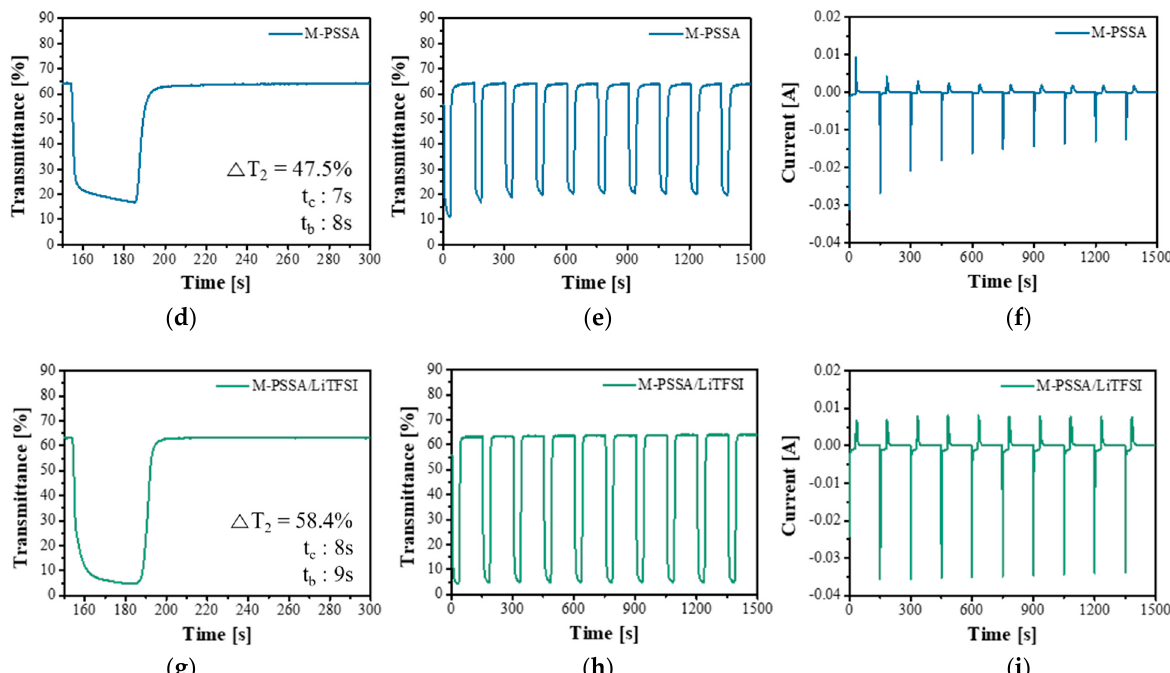
Figure 5. Transmittance vs. time of electrochromic devices (ECDs) of various types of electrolytes ( a , b ) MXene/Bis(trifluoromethylsulfonyl)amine lithium salt (MXene/LiTFSI), ( d , e ) poly(4-styrenesulfonic acid) crosslinked with MXene (M-PSSA) and ( g , h ) 1:20 LiTFSI in MXene-PSSA(M-PSSA/LiTFSI) and current vs. time of ECDs of various types of electrolytes ( c ) LiTFSI, ( f ) PSSA ( i ) 1:20 LiTFSI in PSSA at the wavelengths of 600 nm for square-wave potentials between − 1.2 V (30 s) and 0.5 V (120 s).